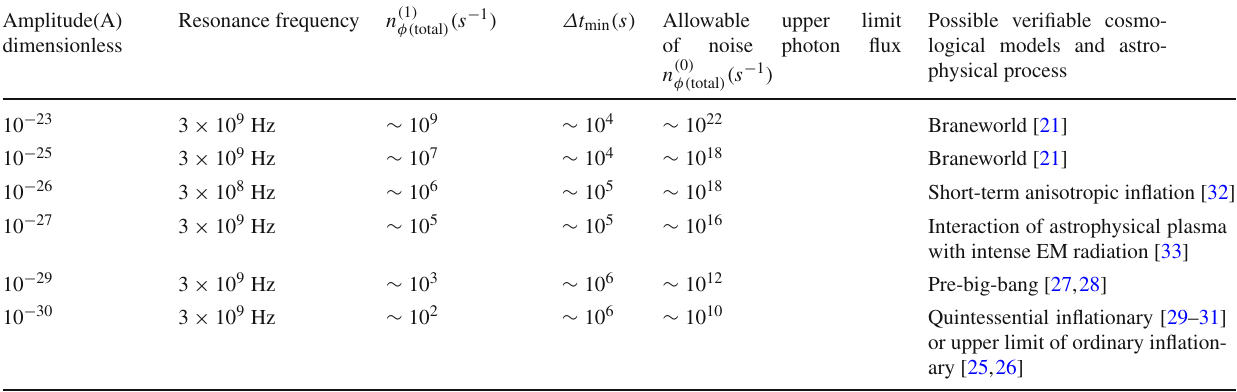
Table 2 Displaying condition in 3DSR system (in laboratory scale) for the HFGWs (having possible additional polarizations) from some typical cosmological models and high-energy astrophysical